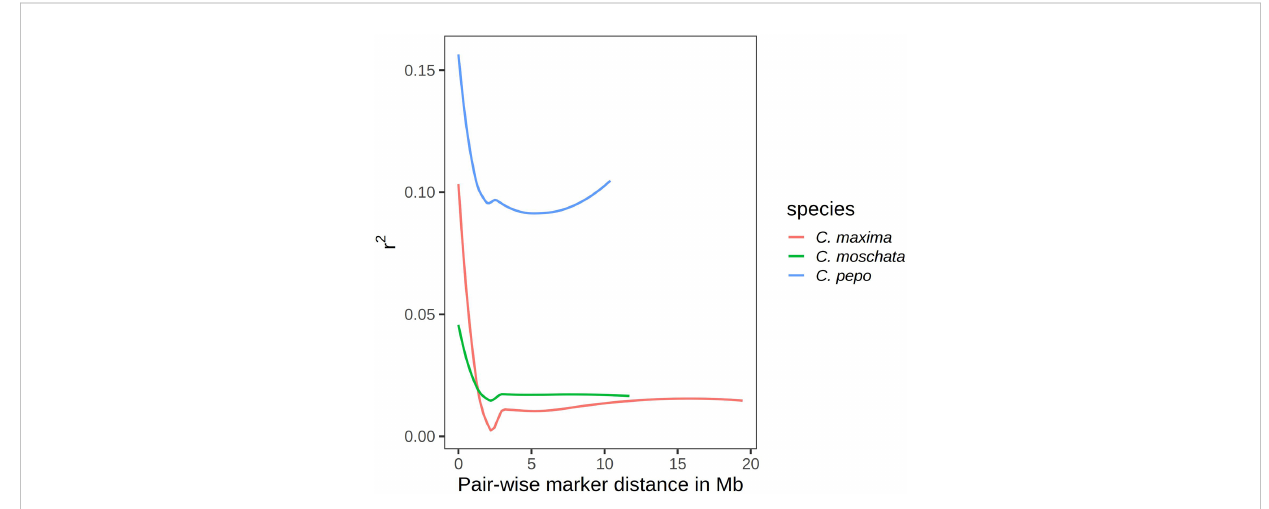
FIGURE 5 Curves showing r 2 value as a measure of LD on the y-axis and pair-wise distance between markers in megabases on the